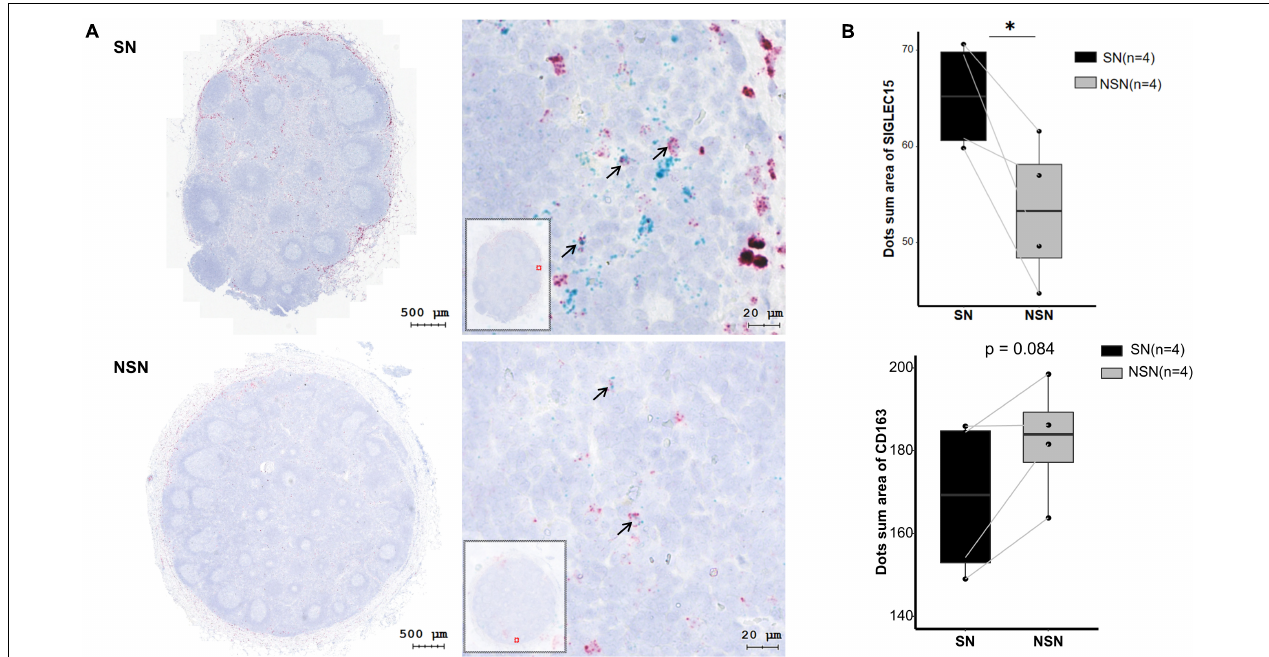
FIGURE 3 | SIGLEC15 and CD163 mRNA expression detected by RNAscope. (A) Representative images of RNAscope of SIGLEC15 (green) and CD163 (red) in sentinel lymph node (SN) and non-sentinel lymph node (NSN). (B) Quantification of the expression of SIGLEC15 and CD163 mRNA by RNAscope. ∗ p < 0.05, with paired t